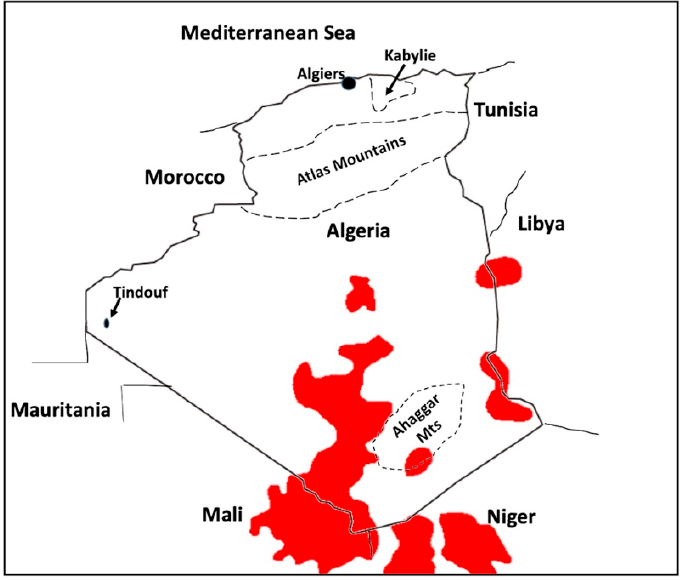
Figure 3. Locations and regions mentioned in the text in relation to desert locust activity and insecurity in Algeria. Primary breeding areas in red.